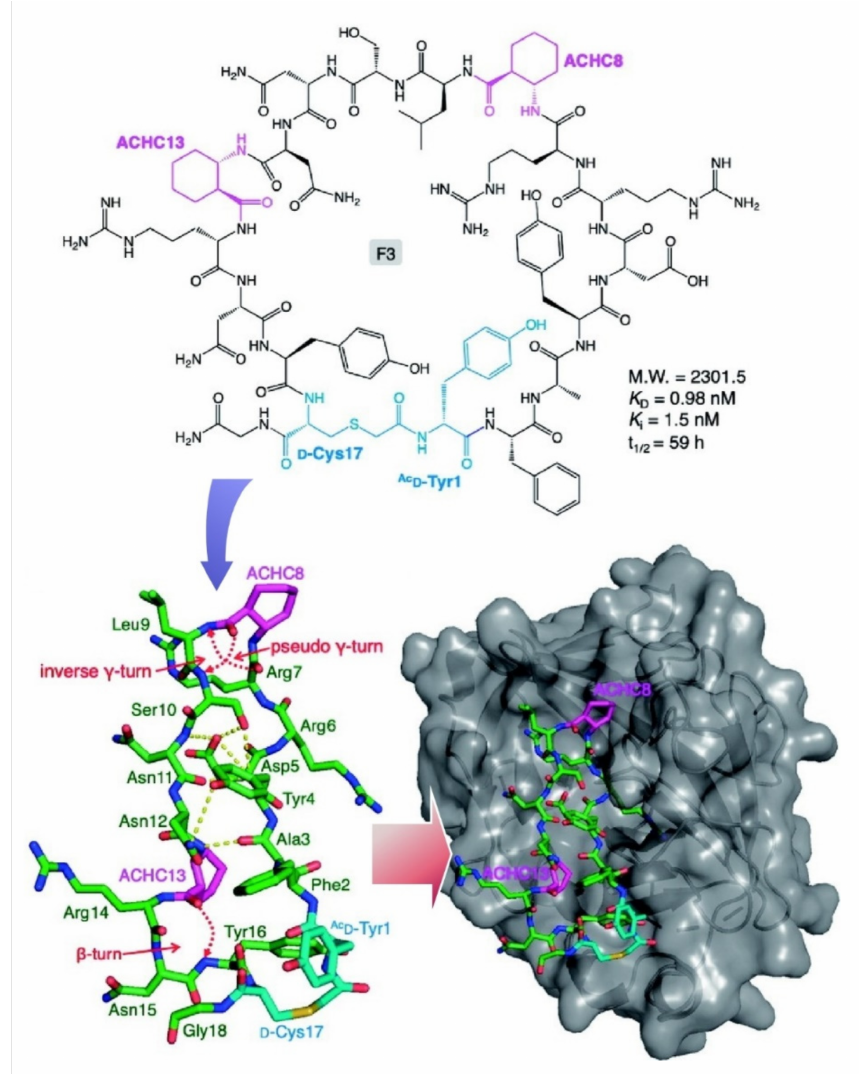
Figure 18. Selected peptide binders to the human contact activation protease factor XIIa (FXIIa) with binding based on logical folding of the binder proteins through formation of anti-parallel β - sheet structure supported by two γ -turns, a pseudo γ -turn and an inverse γ -turn. Reprinted with permission from Reference [160]. Copyright 2021 Chemical Society of